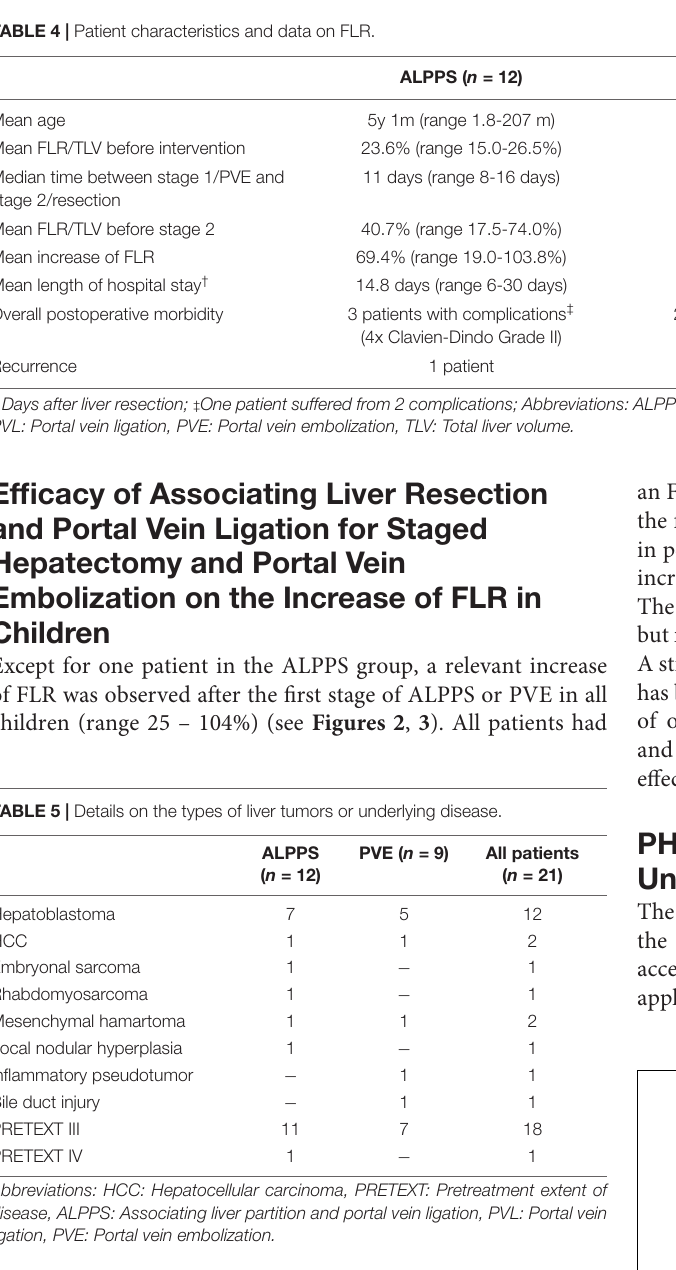
TABLE 6 | Applied criteria and reason for performing ALPPS or PVE/PVL.